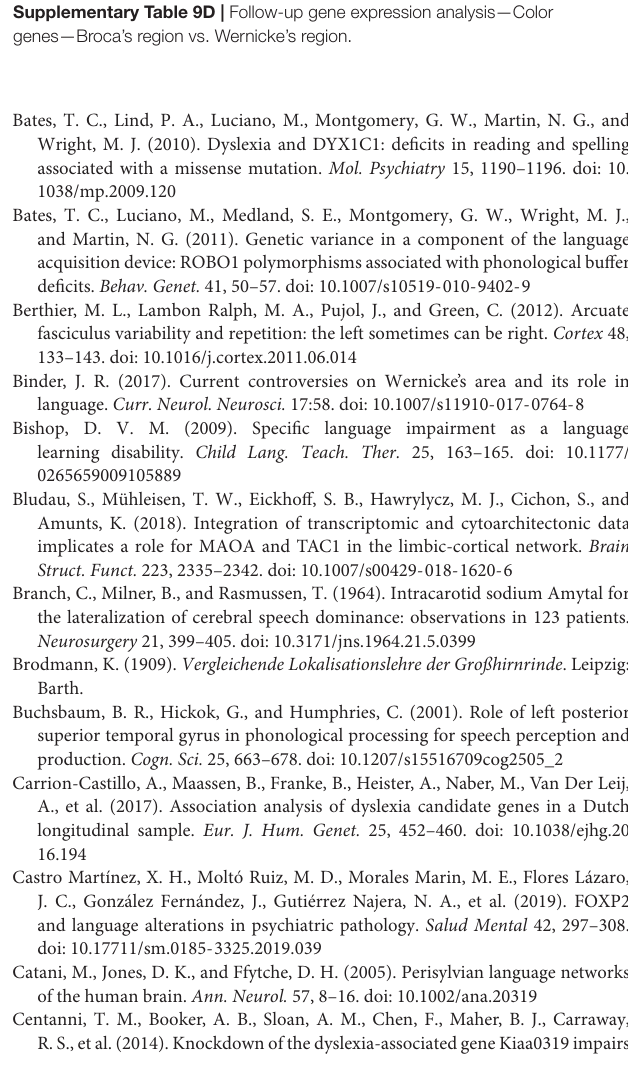
Supplementary Table 5 | Literature evaluation—Clinical categories found in research articles. Supplementary Table 6A | Gene expression analysis—Random genes used as negative control. Supplementary Table 6B | Gene expression analysis—Color genes used as negative control.